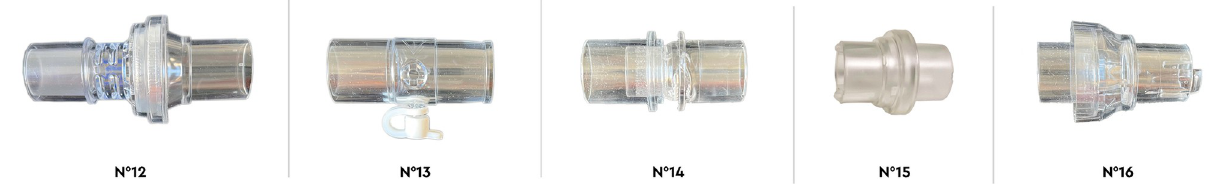
Fig 2. Five models of industrial leak valves: (1) whisper swivel II exhalation port (reference 12), (2) disposable fixed exhalation port (DEP) with cap single-use (reference 13), (3) leak valve row fixed (reference 14), (4) WILAsilent swivel disposable exhalation port (reference 15), and (5) Silentflow 2 exhalation system (reference 16).